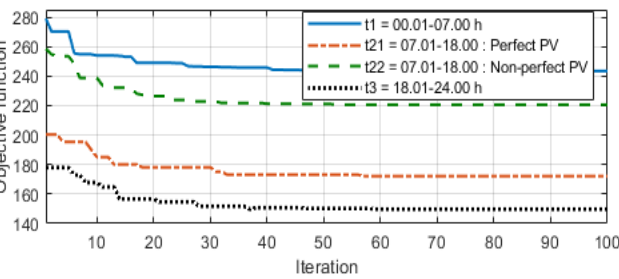
Figure 9. Convergence curve of FA for the indoor temperature weight tuning. Table 2. Weighs of indoor temperature deviations for DMPCs.